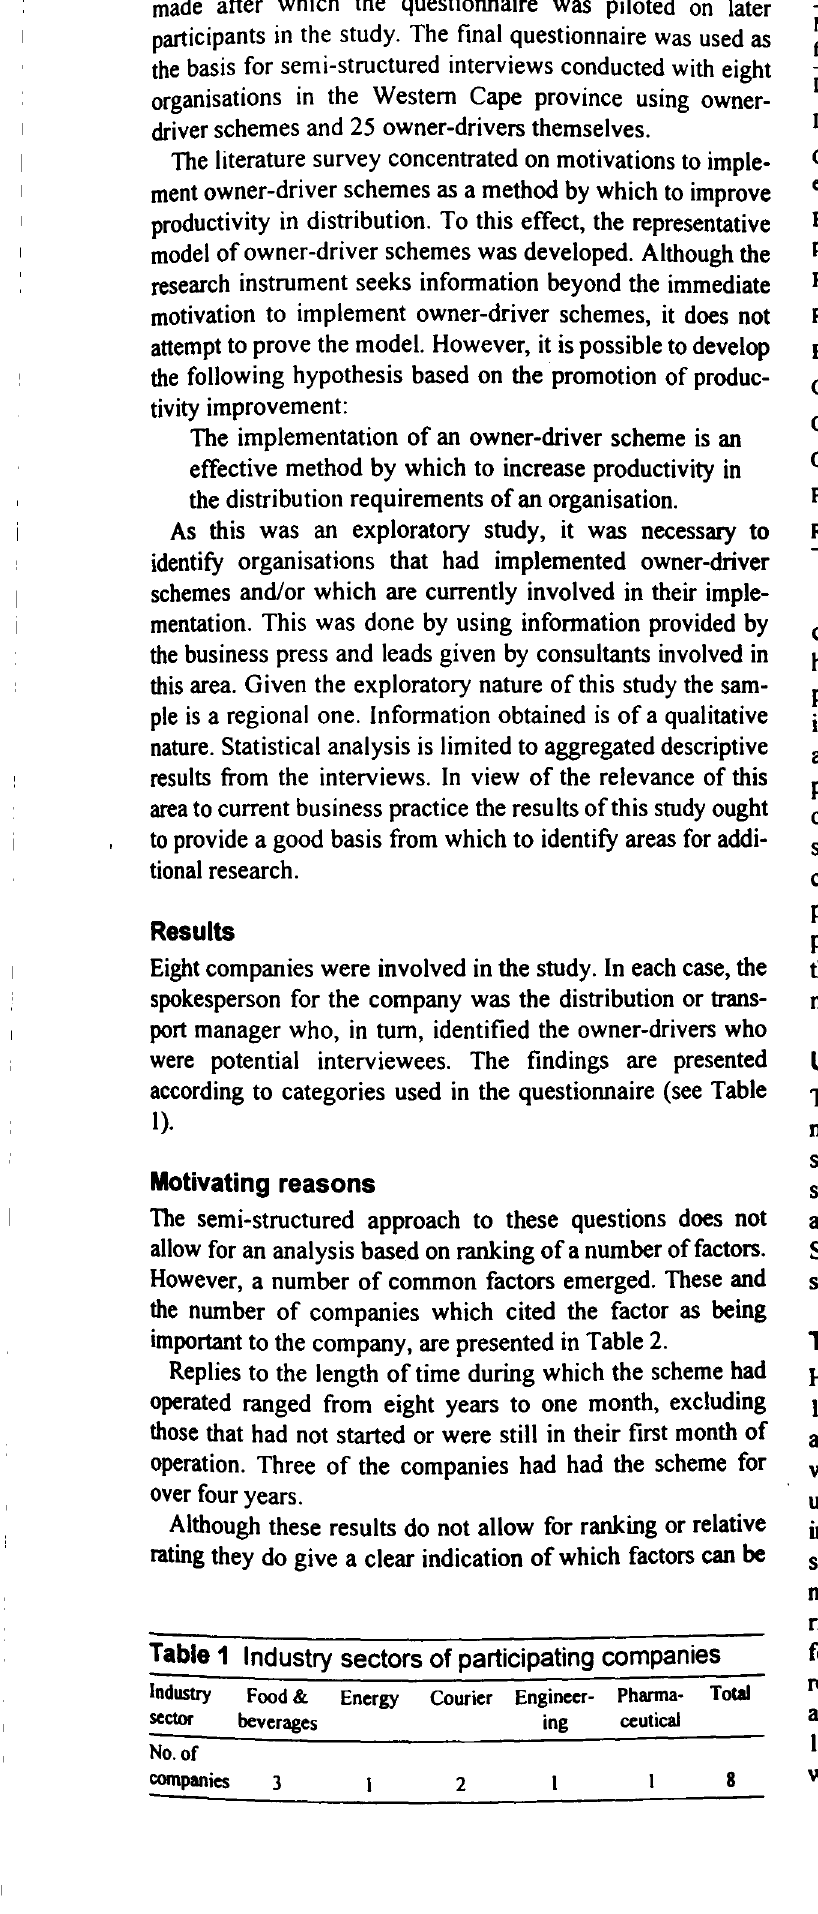
Table 2 Motivation factors cited by participating